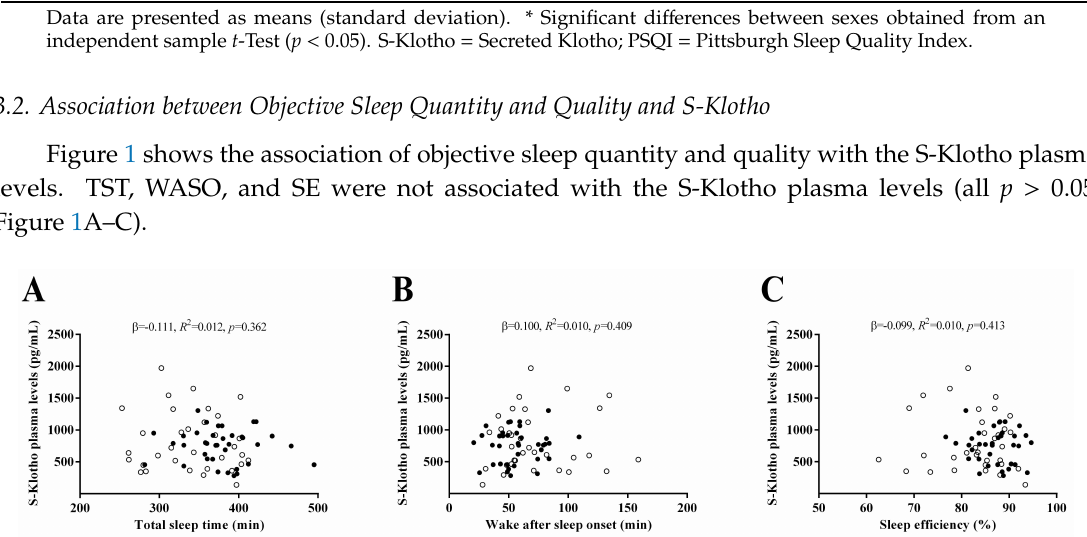
Figure1. Association of objective sleepquantity and quality with the S-Klotho plasmalevels in sedentary middle-aged adults. β (standardized regression coe ffi cient), R 2 , and p from a simple linear regression analysis. Significant p values ( < 0.05) are highlighted in bold. Open circles represent men, close circles represent women, and the straight solid line represents the regression line. S-Klotho = Secreted